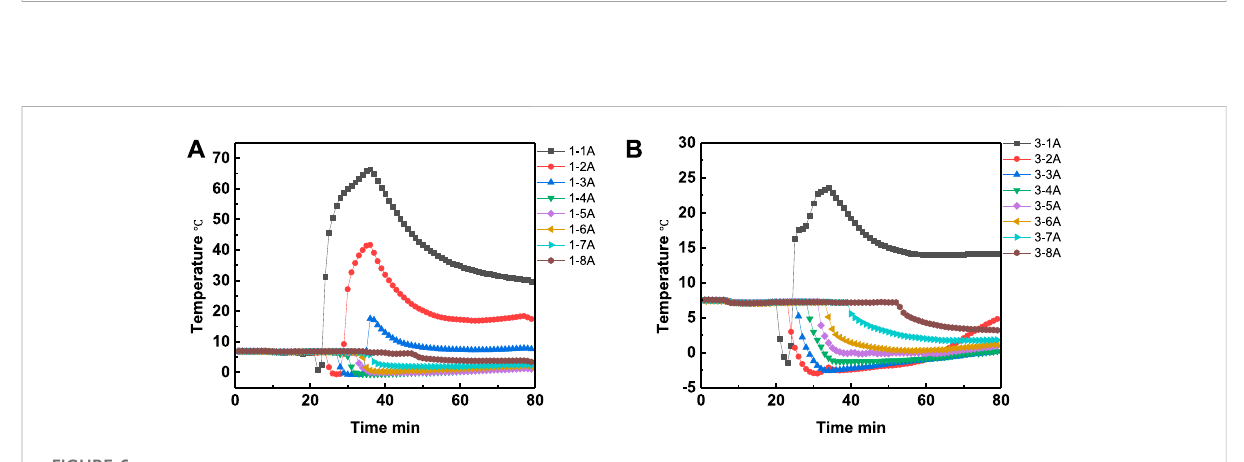
FIGURE 6 Temperature changing comparison versus time at different positions of experiment 1 (A) and experiment 3 (B) ,